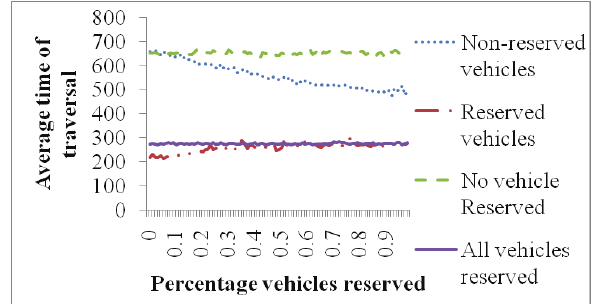
Fig. 7. Comparative analysis of road reservation system for different percentage of vehicles reserved.